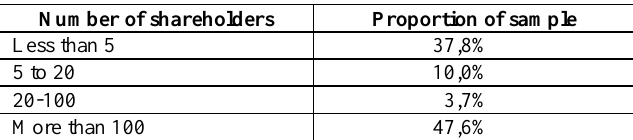
Table 2: Shareholder distribution of respondents